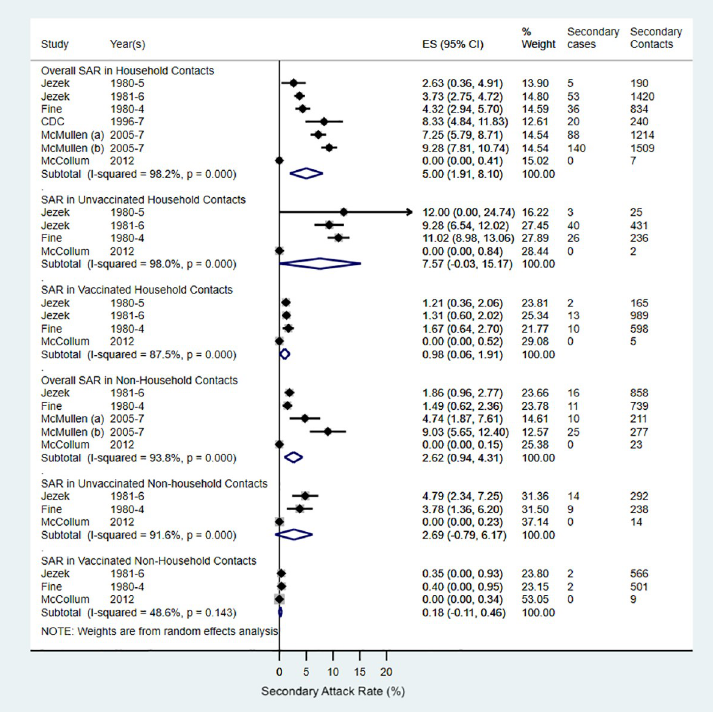
Fig 4. Forest plot of SARs in the DRC (CB strain) stratified by household contacts, and contact vaccination status. Created using STATA . Diamonds represent summary SAR . P values following the I 2 statistics represent the χ 2 test for heterogeneity . SAR were calculated as number of secondary cases/number of contacts (see S5 Table). Weights are from random effects analysis. McMullen (a) calculations use number of secondary cases and contacts identified from single transmission chains while (b) uses total secondary cases and contacts reported by each case and contact. Method (b) follows Fine et al methods. CDC[43] and McMullen[39] do not report SARs that are stratified by vaccination status therefore overall household SARs was decidedly included in the forest plot